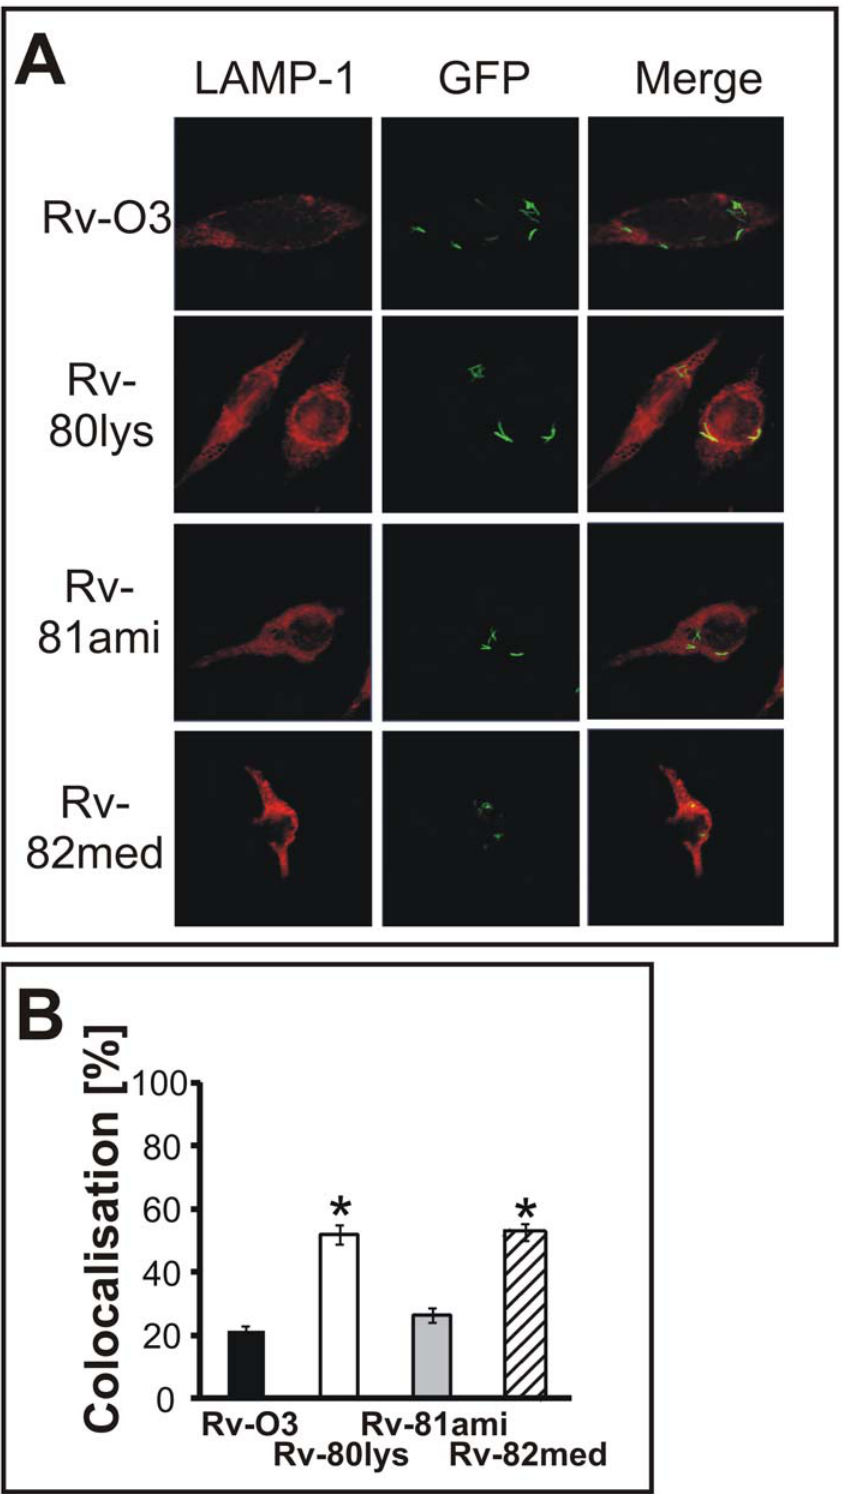
Figure 6. Co-localization of Mtb with LAMP-1-expressing phagosomes. Panel A: THP-1-derived macrophages were infected with GFP- expressing Mtb strains (Rv-03, Rv-80lys, Rv-81ami and Rv-82med). Bacteria (green spots) inside LAMP-1-positive phagosomes (red) produce a yellow signal indicating co-localization (merged). Panel B: The percent co-localization was determined by visual scoring of yellow spots after 72 h of infection. We analyzed 126 macrophages for Rv-80lys, 164 for wild type, 168 for complemented, and 127 for Rv-82med and scored 534 bacterial cells for Rv-80lys, 1,307 for wild type, 848 for Rv-81ami, and 402 for Rv-82med. Mtb Rv-03 (black bar; 21.2 6 1.6%), Rv-80lys (white bar; 52.0 6 3.0%), Rv- 81ami (grey bar; 26.4 6 2.2%) and Rv-82med (dashed bar; 52.6 6 2.8%). * P , 0.001 versus Rv-03 and Rv-81ami using the Student-Newman-Keuls Method; bars represent mean 6 standard error.